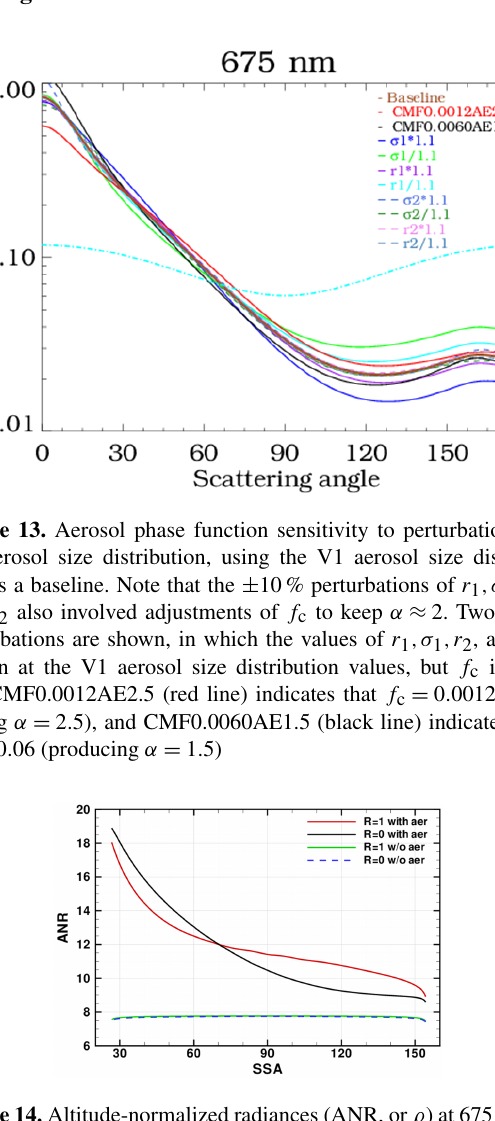
Figure 14. Altitude-normalized radiances (ANR, or ρ ) at 675nm as a function of SSA (or (cid:50) ) under aerosol-free and aerosol conditions, with both non-reflecting ( R = 0) and perfectly reflecting ( R = 1) surface conditions. The values of h and h n are 25.5 and 40.5km, respectively.